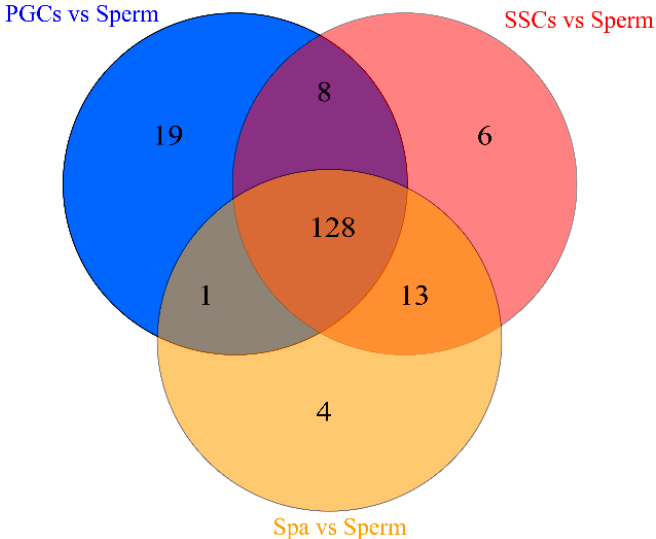
Figure 1. Venn analysis of the differentially expressed miRNAs in the three